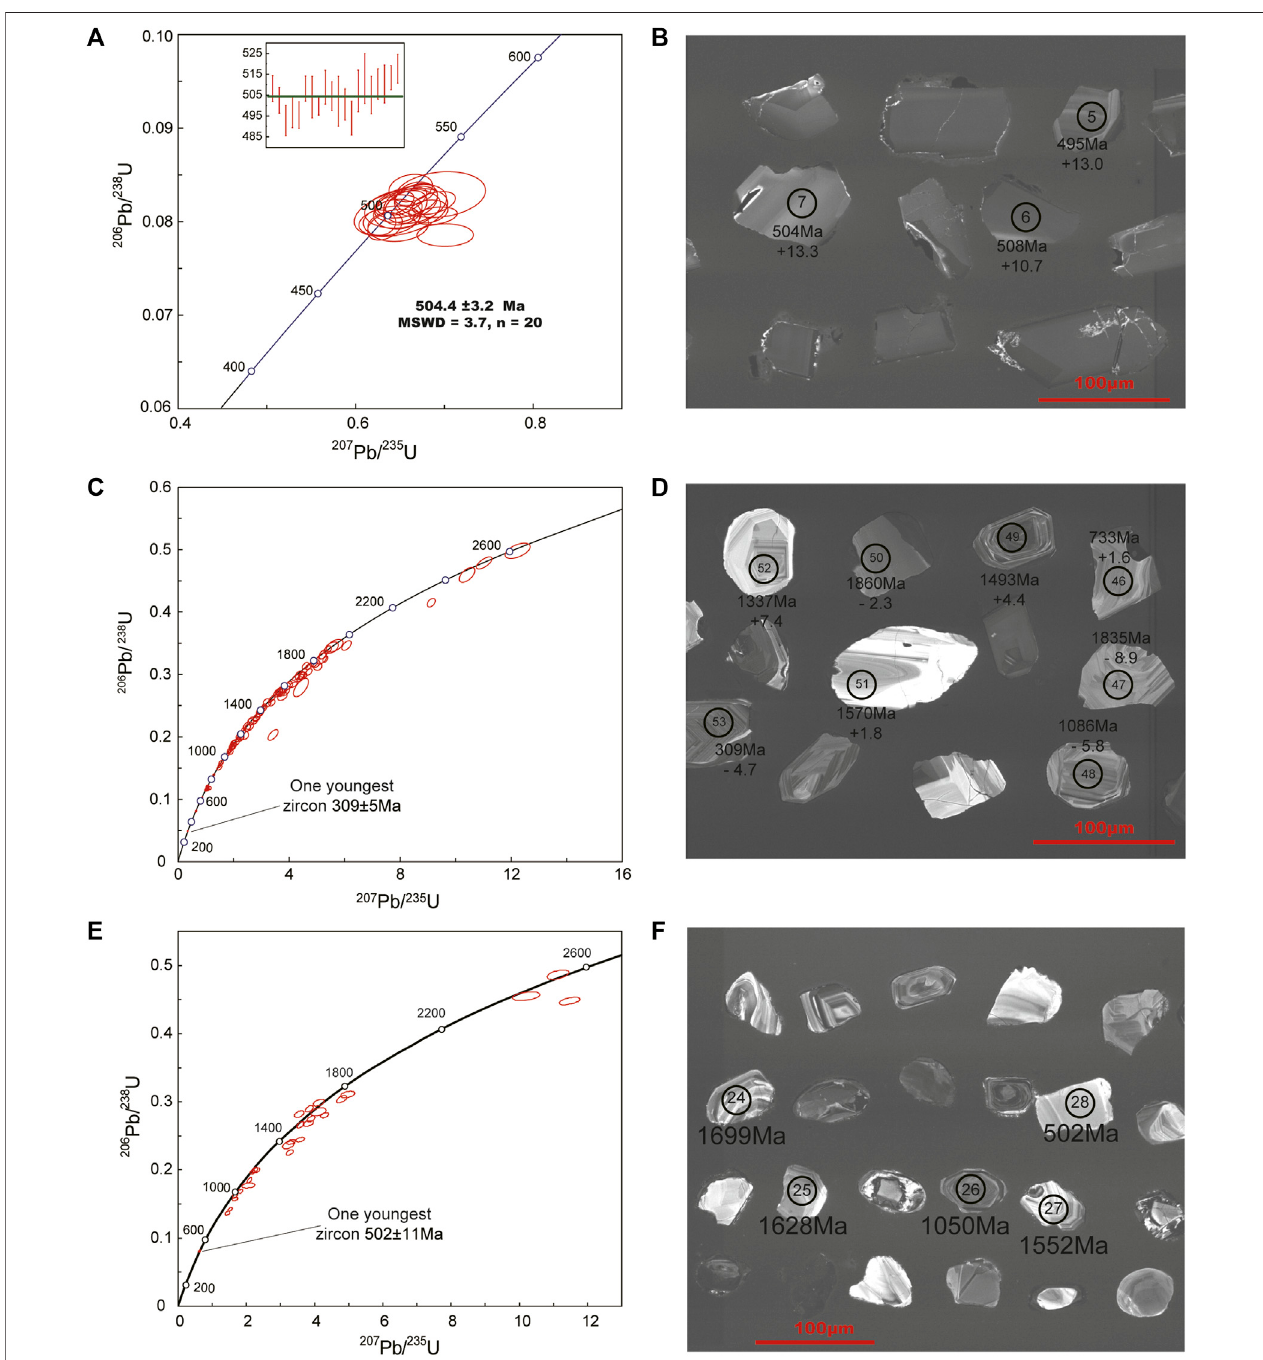
FIGURE6 | CL images and Concordia U-Pb diagram forgabbros and sandstoneofthe Huaniushan complex in Beishan. (A and B) are LA-ICP-MSU-Pb age and CL images ofgabbro(20HNS27); (Cand D) areLA-ICP-MSU-Pb age and CL images ofthe sandstone in thecomplex(20HNS34); (E and F) areLA-ICP-MS U-Pb age and CL images of sandstone (20HNS15) in the northern part of the